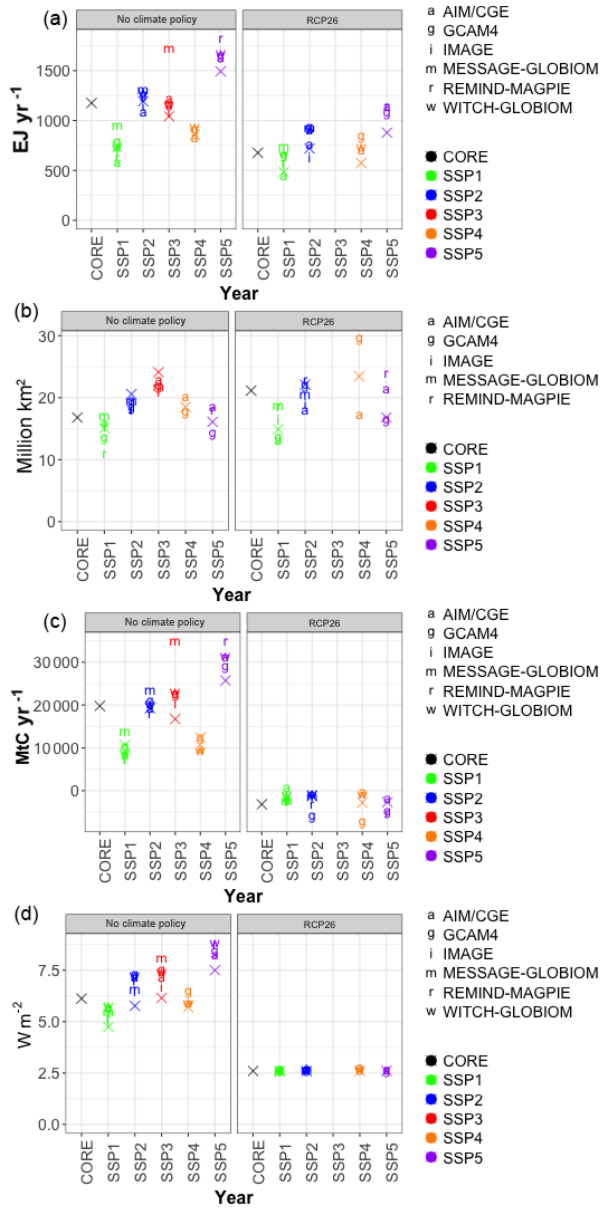
Figure 17. Global primary energy (a) , global cropland (b) , global fossil fuel and industrial CO 2 emissions (c) , and total radiative forc- ing (d) in 2100. GCAM v5.1 results are shown using “X”. Data from the SSP database (Riahi et al., 2017a) are shown as lowercase letters. Colors indicate SSP. The left panels are the no climate pol- icy results; the right panels show scenarios that limit 2100 radiative forcing to 2.6Wm − 2